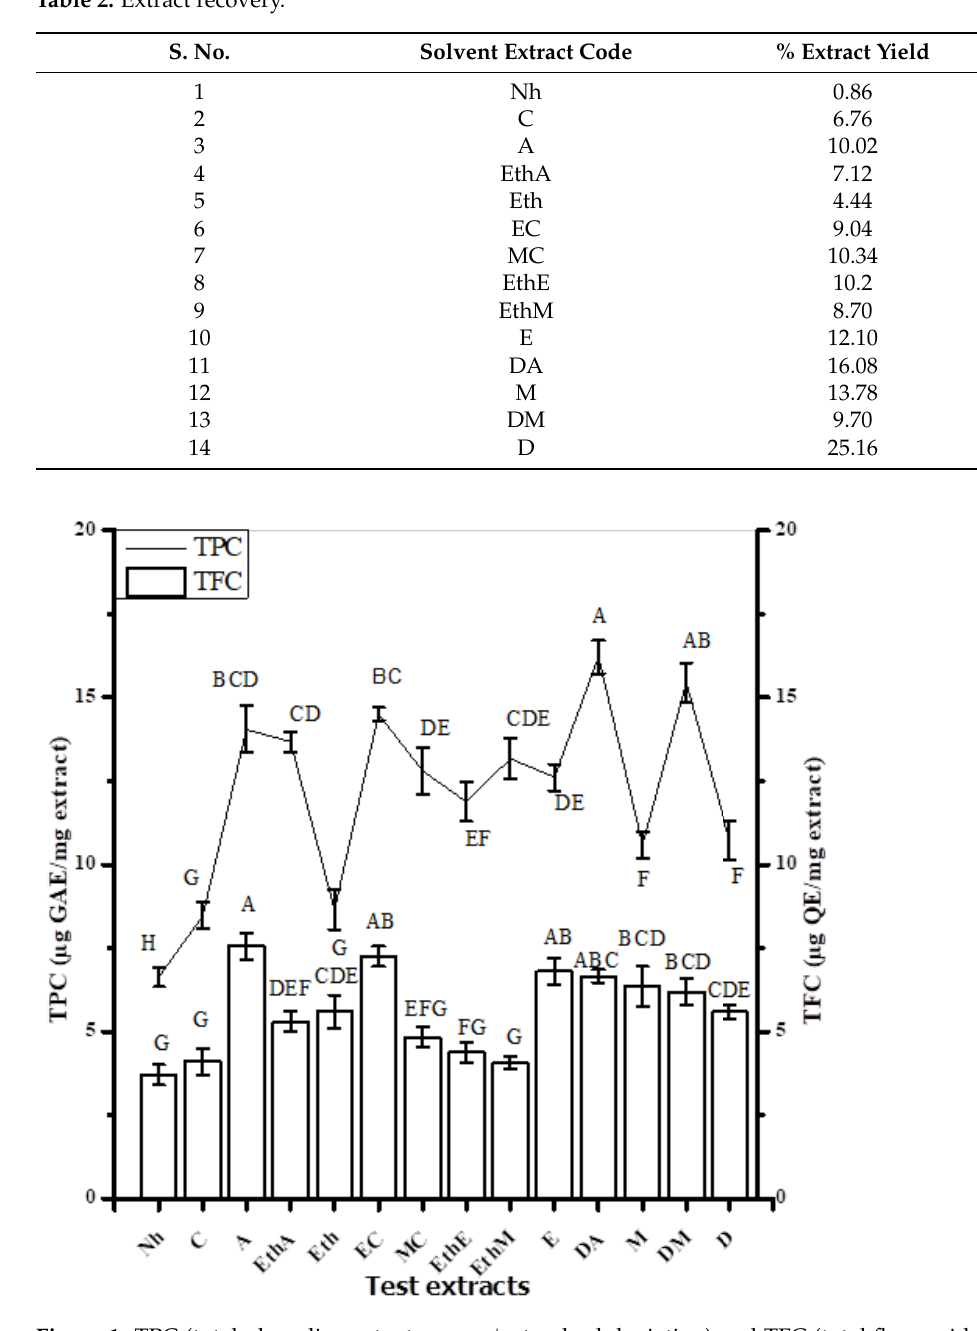
Figure 1. TPC (total phenolic content; mean ± standard deviation) and TFC (total flavonoid con- tents; mean ± standard deviation) are displayed after triplicate investigation. A–H represent the significance of results. Samples that display different alphabets were significantly different at p < 0.05. Table 3. RP HPLC analysis of various solvent extracts of C. tuberculata.